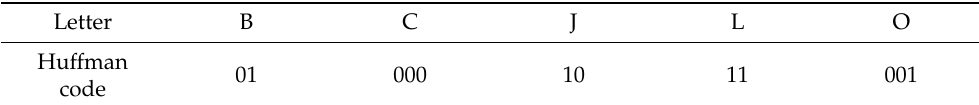
Figure 5. Result of Huffman tree construction. Table 3. Result of Huffman coding for each letter.